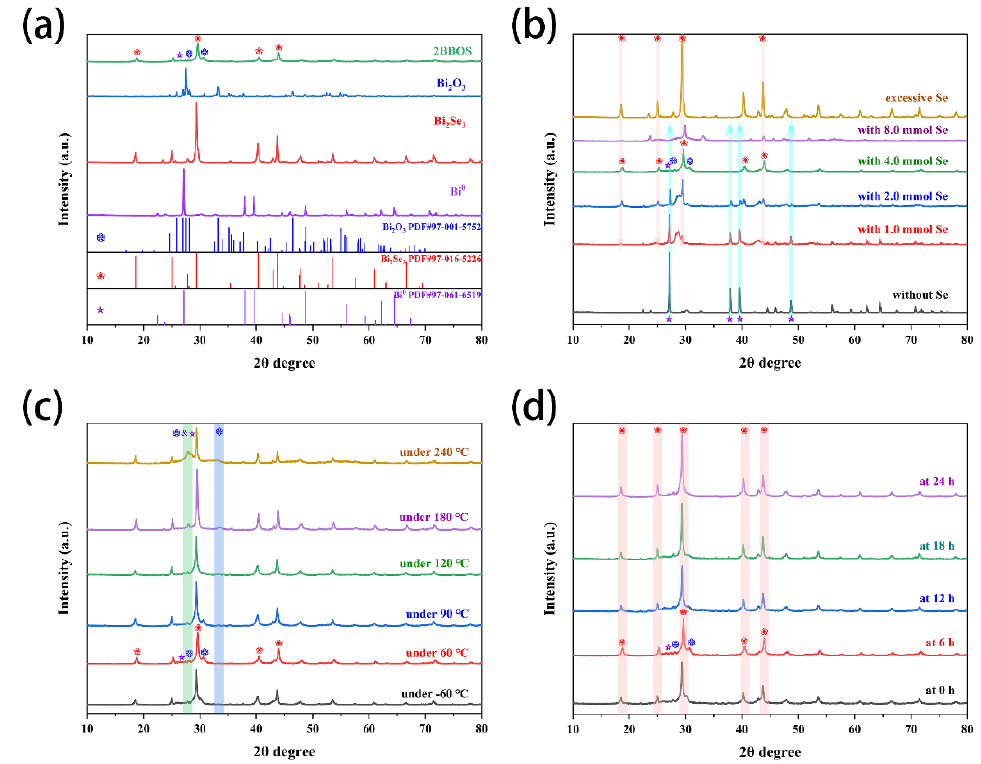
Figure 1. ( a ) The XRD diffractogram corresponding to Bi 0 , Bi 2 Se 3 , Bi 2 O 3 , 2BBOS, and the correspond- ing standard card. ( b ) The effect of adding different moles of selenium powder on BBS. ( c ) The effect of 2BBS samples treated at different temperatures for 6 h on the final product BBOS. ( d ) The effect of different times of processing of 2BBS samples at 60 °C on the BBOS of the final product ( ❄ corresponding to Bi 2 O 3 , ❀ corresponding to Bi 2 Se 3 , and ⭐ corresponding to Bi 0 ).